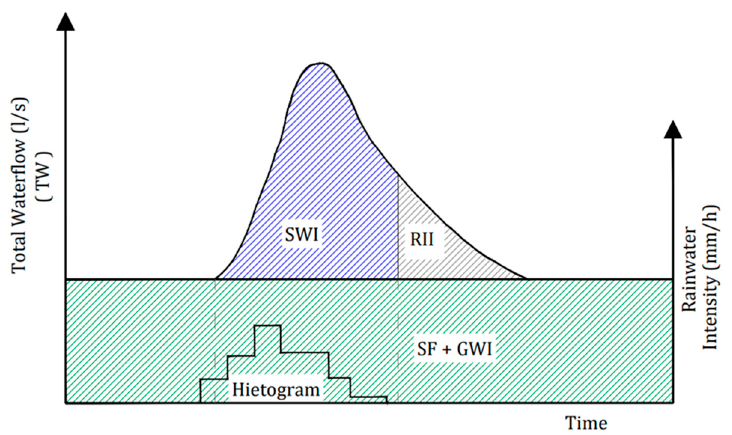
Figure 2. Process of decomposition and quantification of the effluent flow, adapted from [17]. SWI— direct rainwater; RII—rain-induced infiltration; SF + GWI—sanitary flow + underground infiltra- tion.